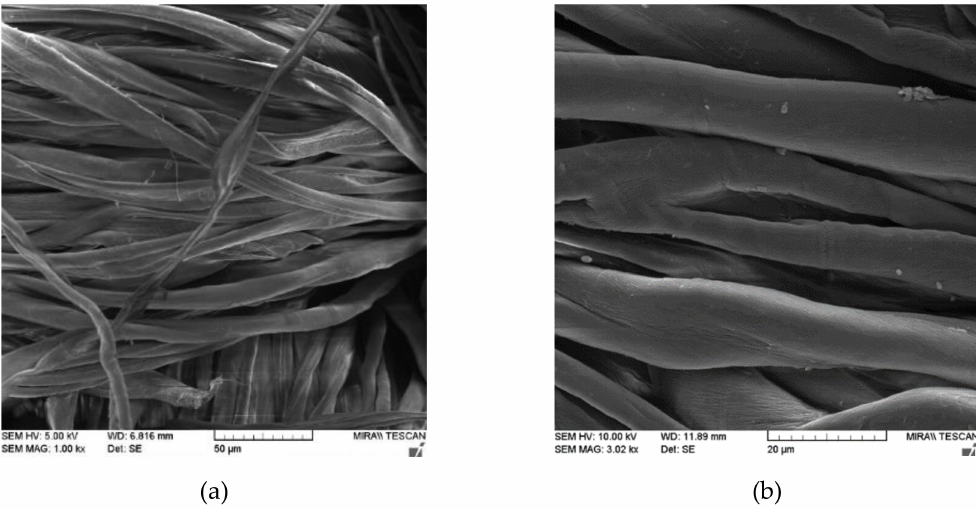
Figure 1. SEM images of standard cotton fabric (CO) in di ff erent magnifications: ( a ) 1000 × , and ( b ) 3000 ×